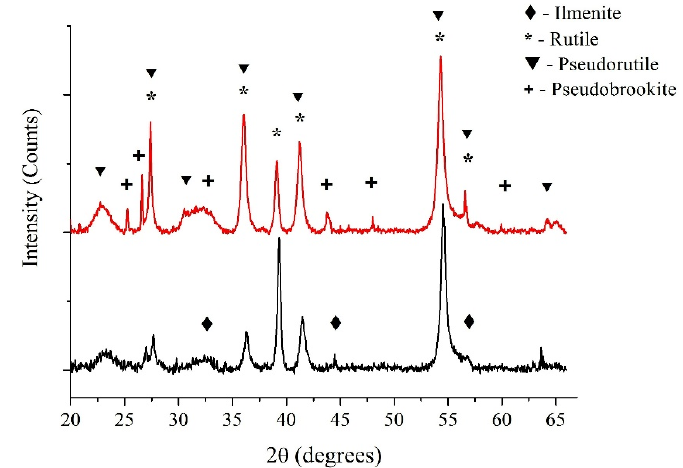
Figure 2. Diffraction patterns of ilmenite concentrate from the Malyshevske deposit before grinding (black line) and after 2 h of grinding (red line).